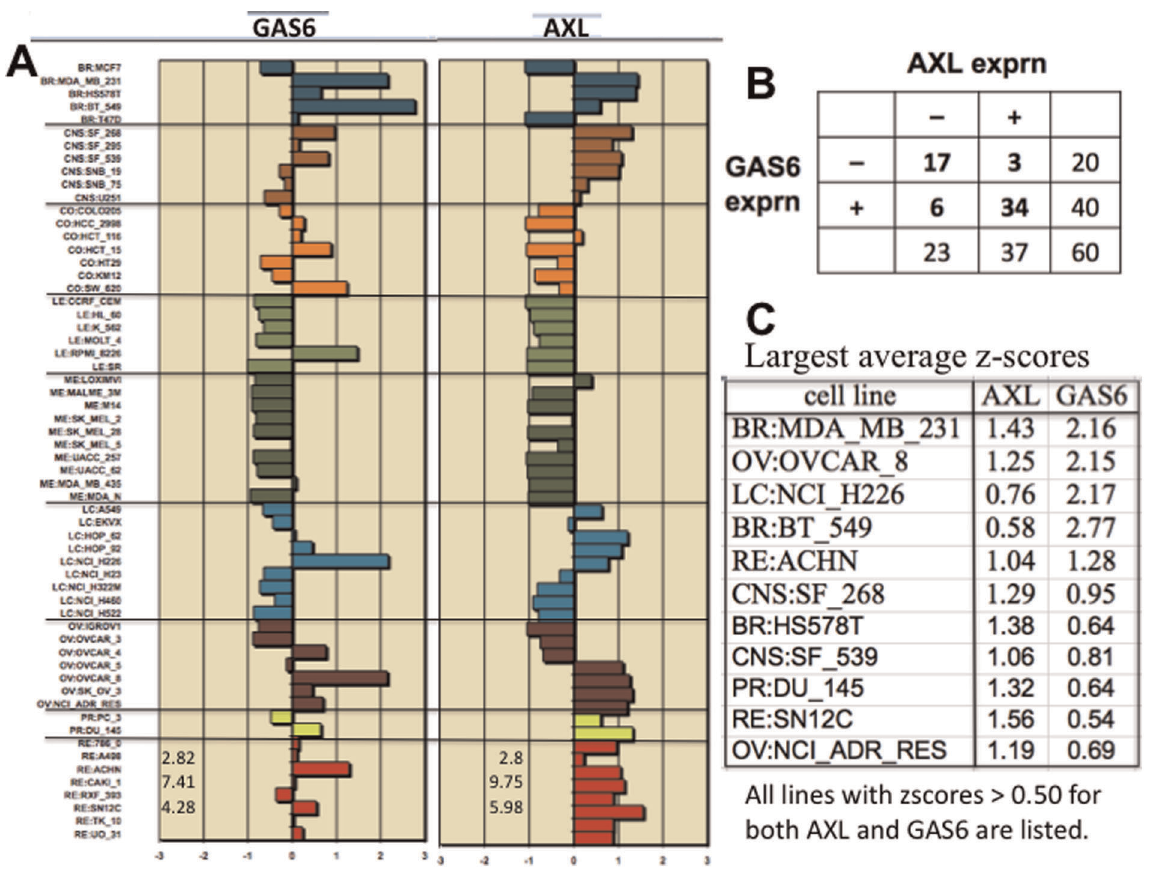
Figure 7. Expression of AXL and its ligand GAS6. (A) Expression level (z-score) of each cell line. (B) Number of cell lines that express AXL, GAS6, both, or neither. (C) Cell lines that strongly express both AXL and GAS6, suggestive of a possible autocrine mechanism.